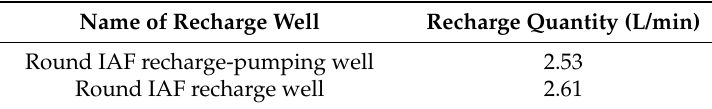
Table 2. Single-well recharge quantity of the comparative recharge